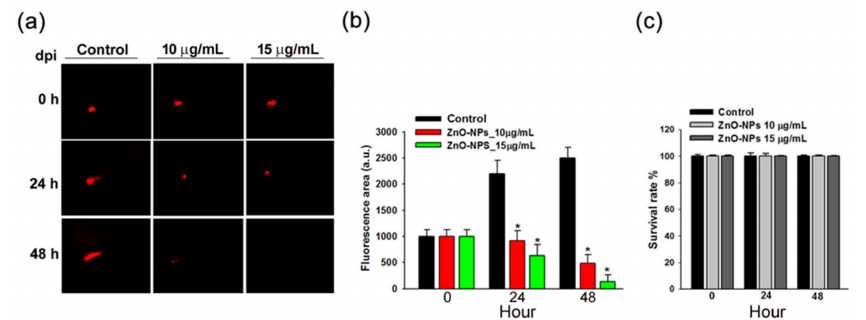
Figure 7. E ff ects of ZnO-NPs on tumor growth of Ca9-22 cells in zebrafish xenograft model. ( a ) The intensity of red fluorescence is proportional to the xenograft tumor size. n = 20 embryos for each group. The scale bar is 16 × magnification. ( b ) The quantitative analysis for the anti-tumor e ffi cacy of ZnO-NPs. ( c ) The survival rate of the zebrafish xenograft model after ZnO-NP treatment is shown. Data represent the mean ± SEM of three independent experiments. * p < 0.05 compared to the vehicle-treated control group.